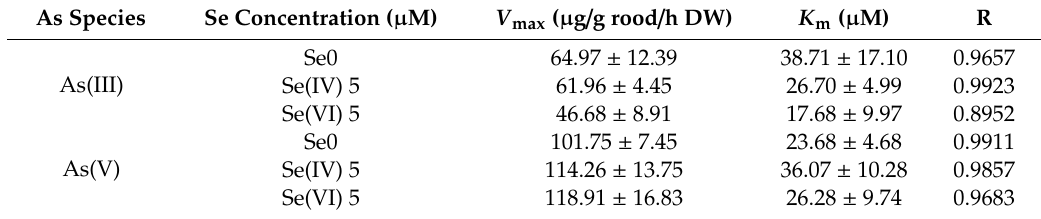
Figure 1. Rate of As(III) and As(V) uptake kinetics at di ff erent levels of Se(IV) or Se(VI) for the plants. Each treatment was replicated three times within 1 h. Functions reported in Table 1 were fitted to the data points. Se0 indicate the control. Table 1. Kinetic parameters for As(III) and As(V) transport in the rice plants grown at di ff erent Se(IV) or Se(VI) levels.